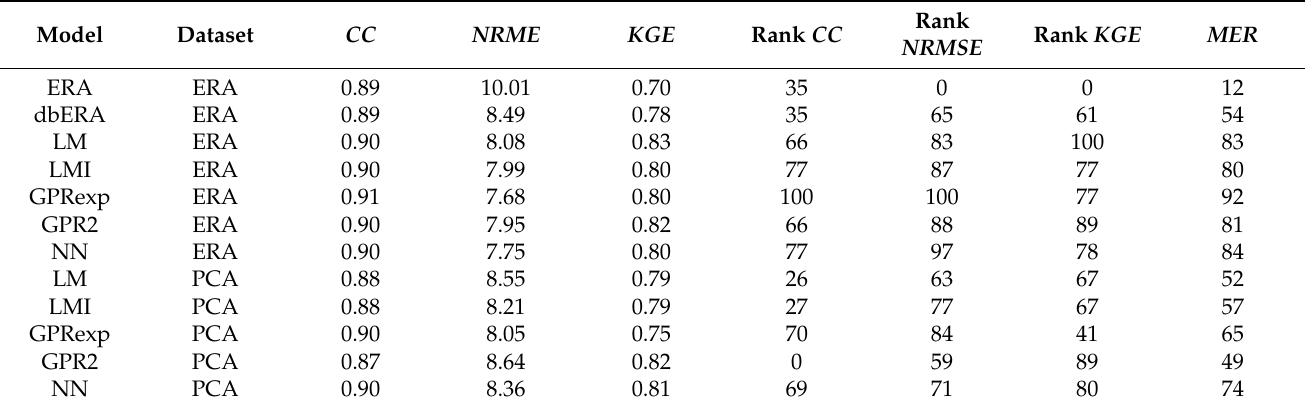
Table 3. Comparison of the model performances for the validation subset from ERA and PCA datasets. MER —mean